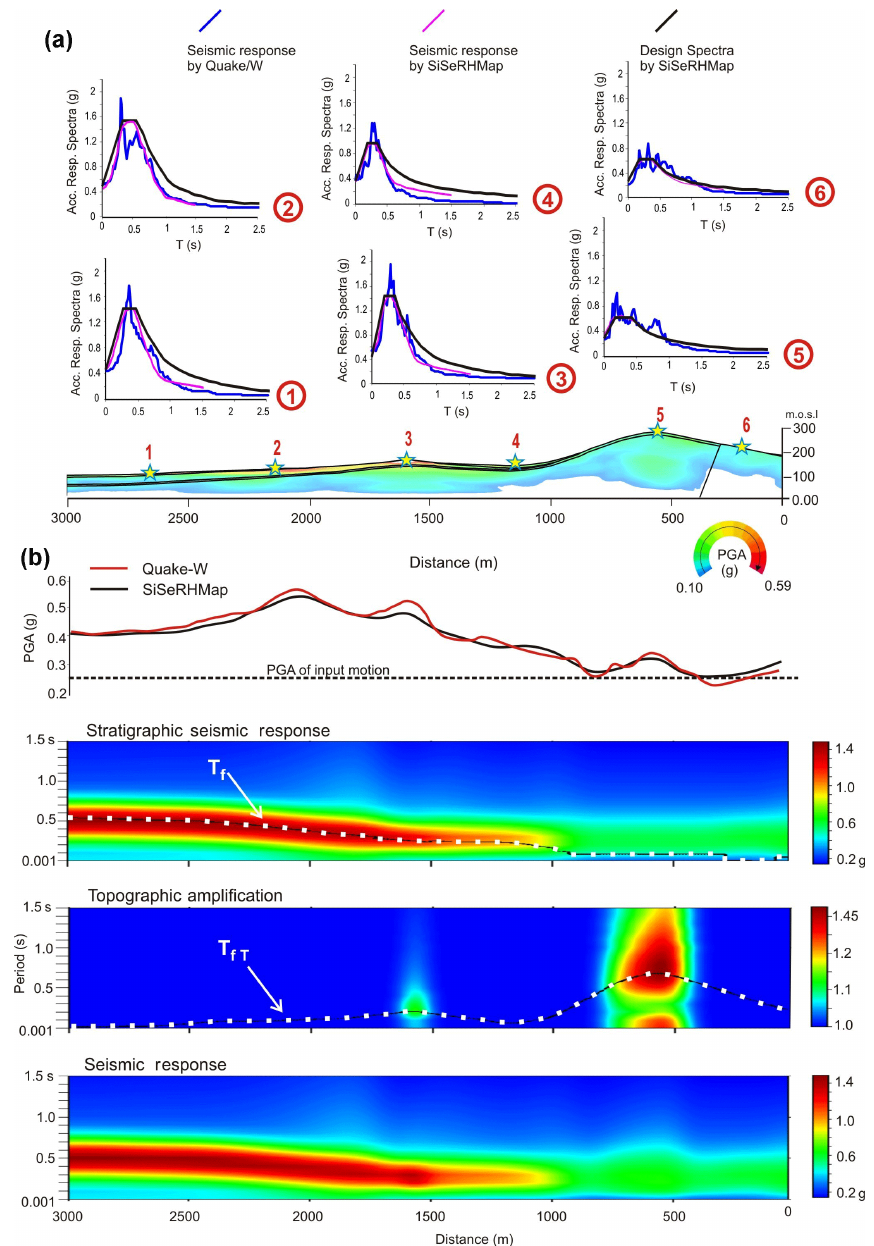
Figure 16. Comparison in some characterized points between the seismic response by SiSeRHMap and the Quake/W finite element method on a cross section showed in Fig.